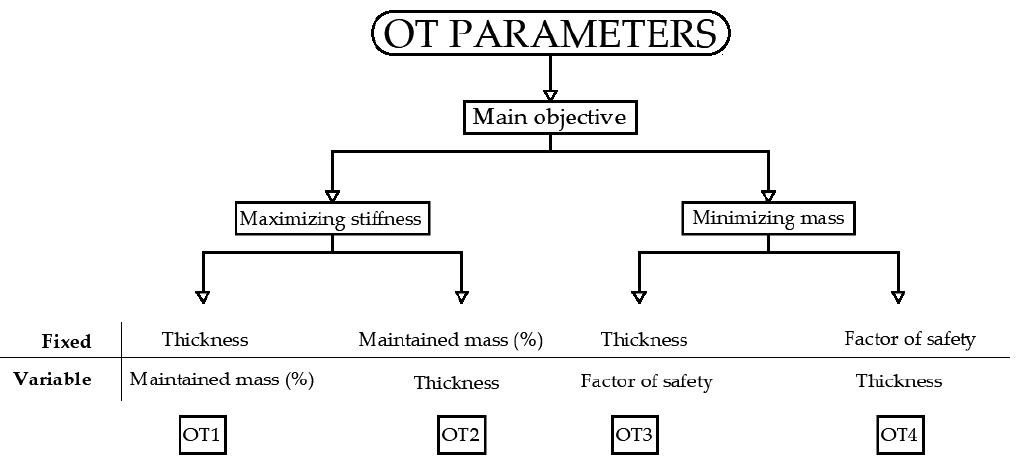
Figure 6. Decision parameters for topology optimization experiments.